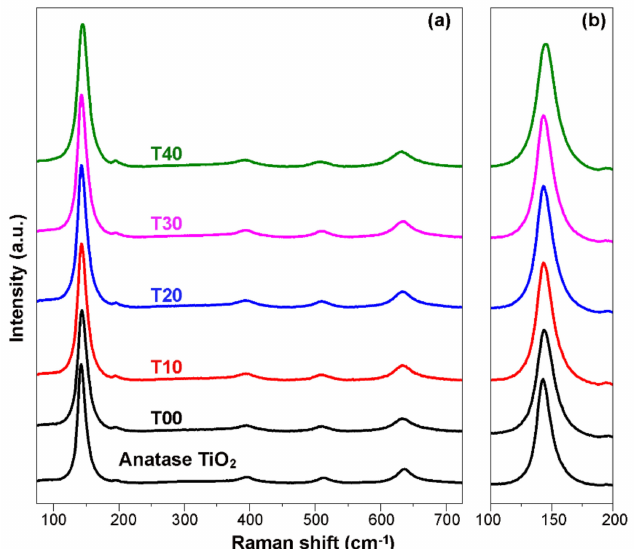
Figure 2. ( a ) Raman spectra of TiO 2 photocatalysts obtained by hydrothermal treatment the sol at different triethanolamine concentrations and ( b ) enlarged Raman